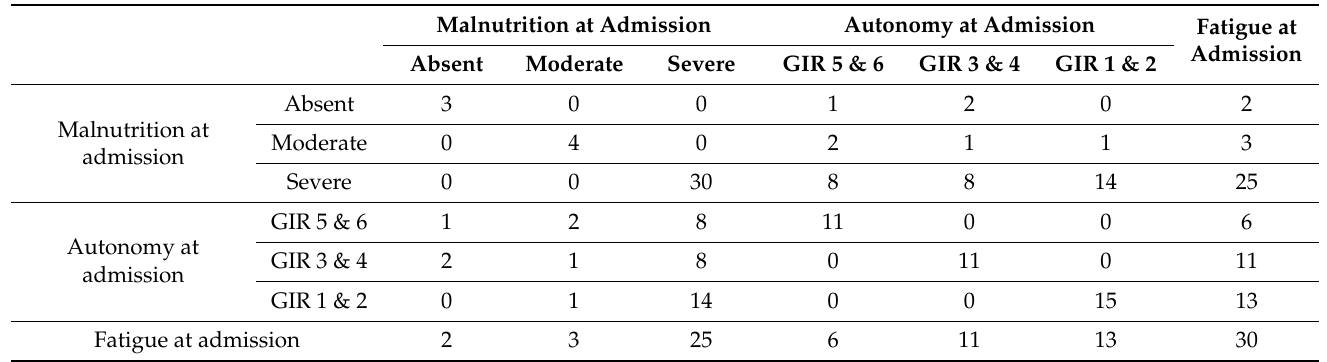
Table 5. Relationship between malnutrition, autonomy and fatigue.